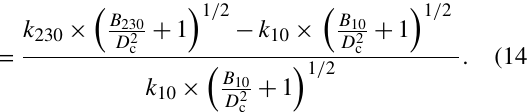
) and the changing rates of PM 1 concentrations ( k PM ab /k PM , k PM and k E . The k E and k PM values represent an apparent changing rate of 1 1 1 ab ab ab = (PM 1 ,t 2 - PM 1 ,t 1 )/ (PM 1 ,t 1 *( t 2 - t 1 ) ). The sensitivity of the change in calculated E